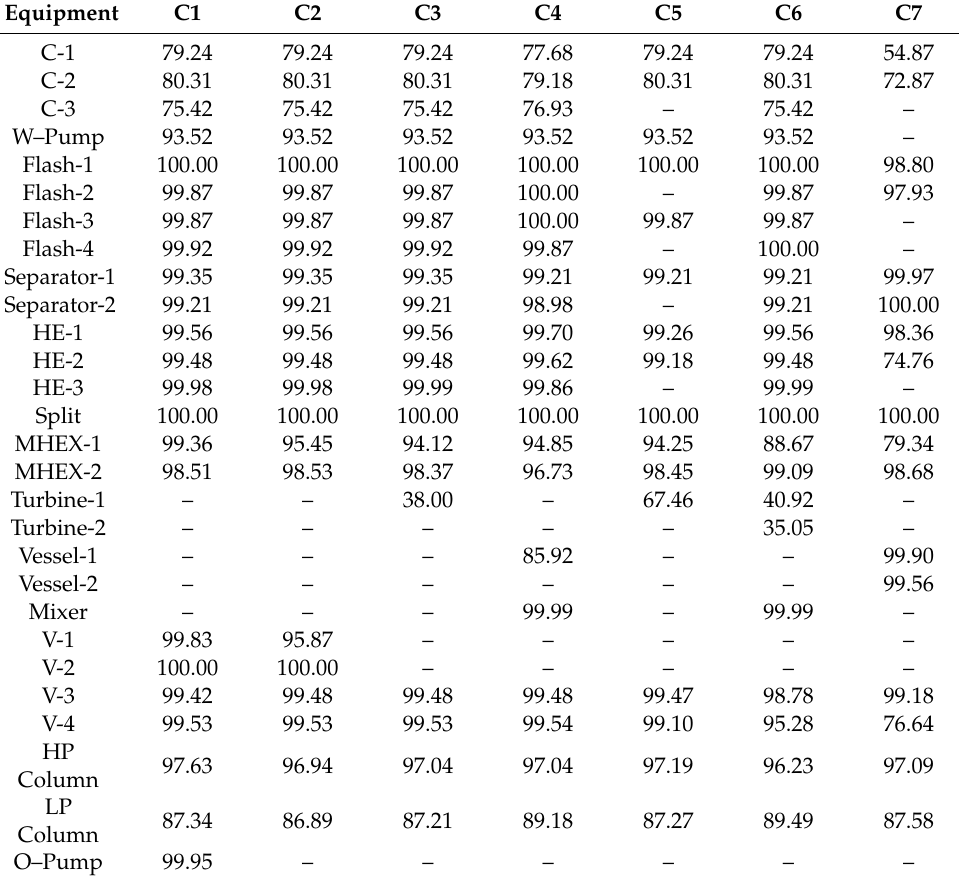
Table 10. Exergy e ffi ciencies (%) of individual equipment in configurations